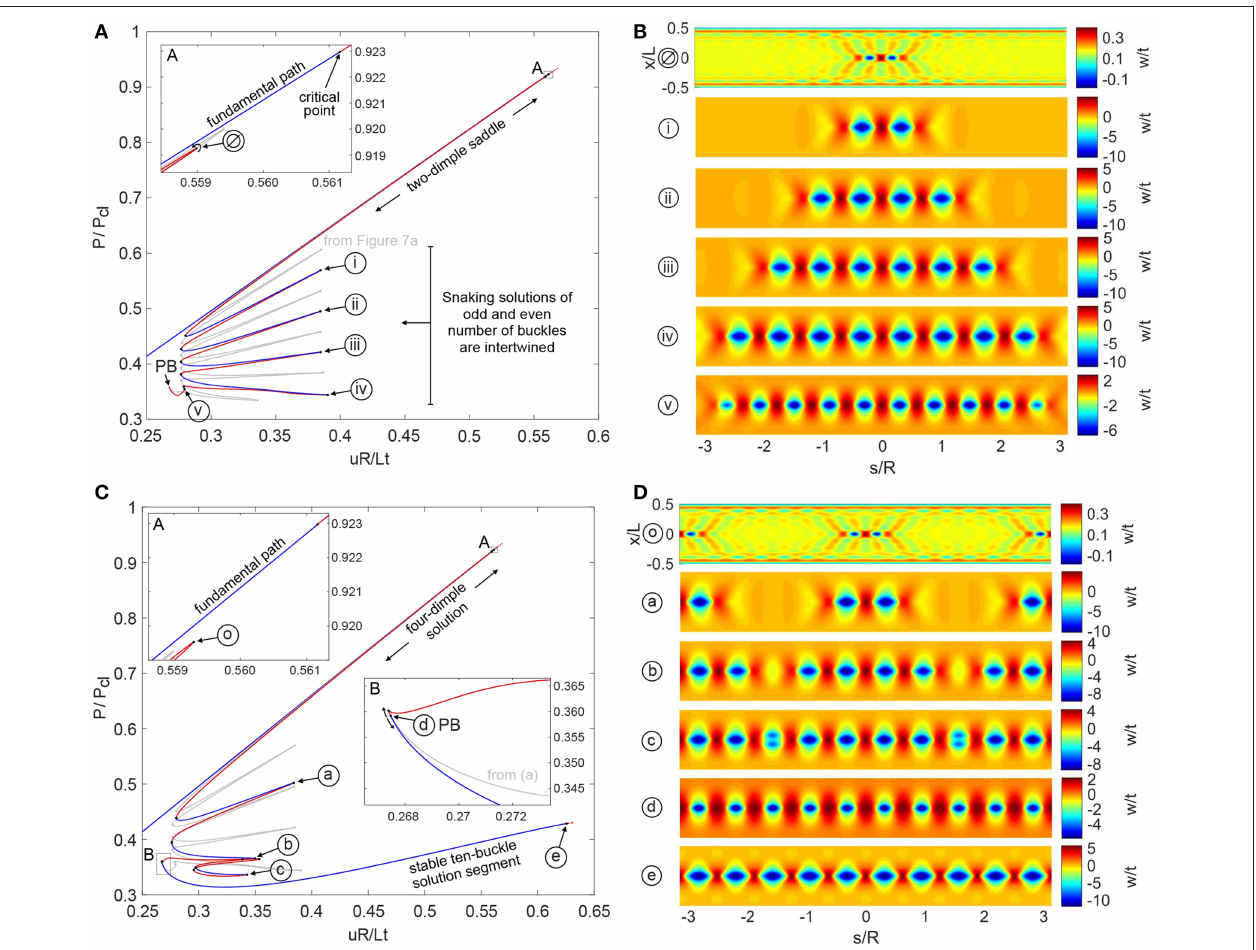
FIGURE 8 | (A) Equilibrium path of a double-dimple post-buckling solution growing sequentially around the cylinder circumference through a series of destabilizations and restabilizations known as cellular buckling (or snaking). (B) Radial deformation mode shapes over the cylinder domain for different points ∅ –v in (A) . (C) Equilibrium path of a four-dimple post-buckling solution growing sequentially through cellular buckling. The single dimple snaking solution in (A) connects to this path at a pitchfork bifurcation (see point d in inset B ). (D) Radial deformation mode shapes over the cylinder domain, for different points o–e in (C) .